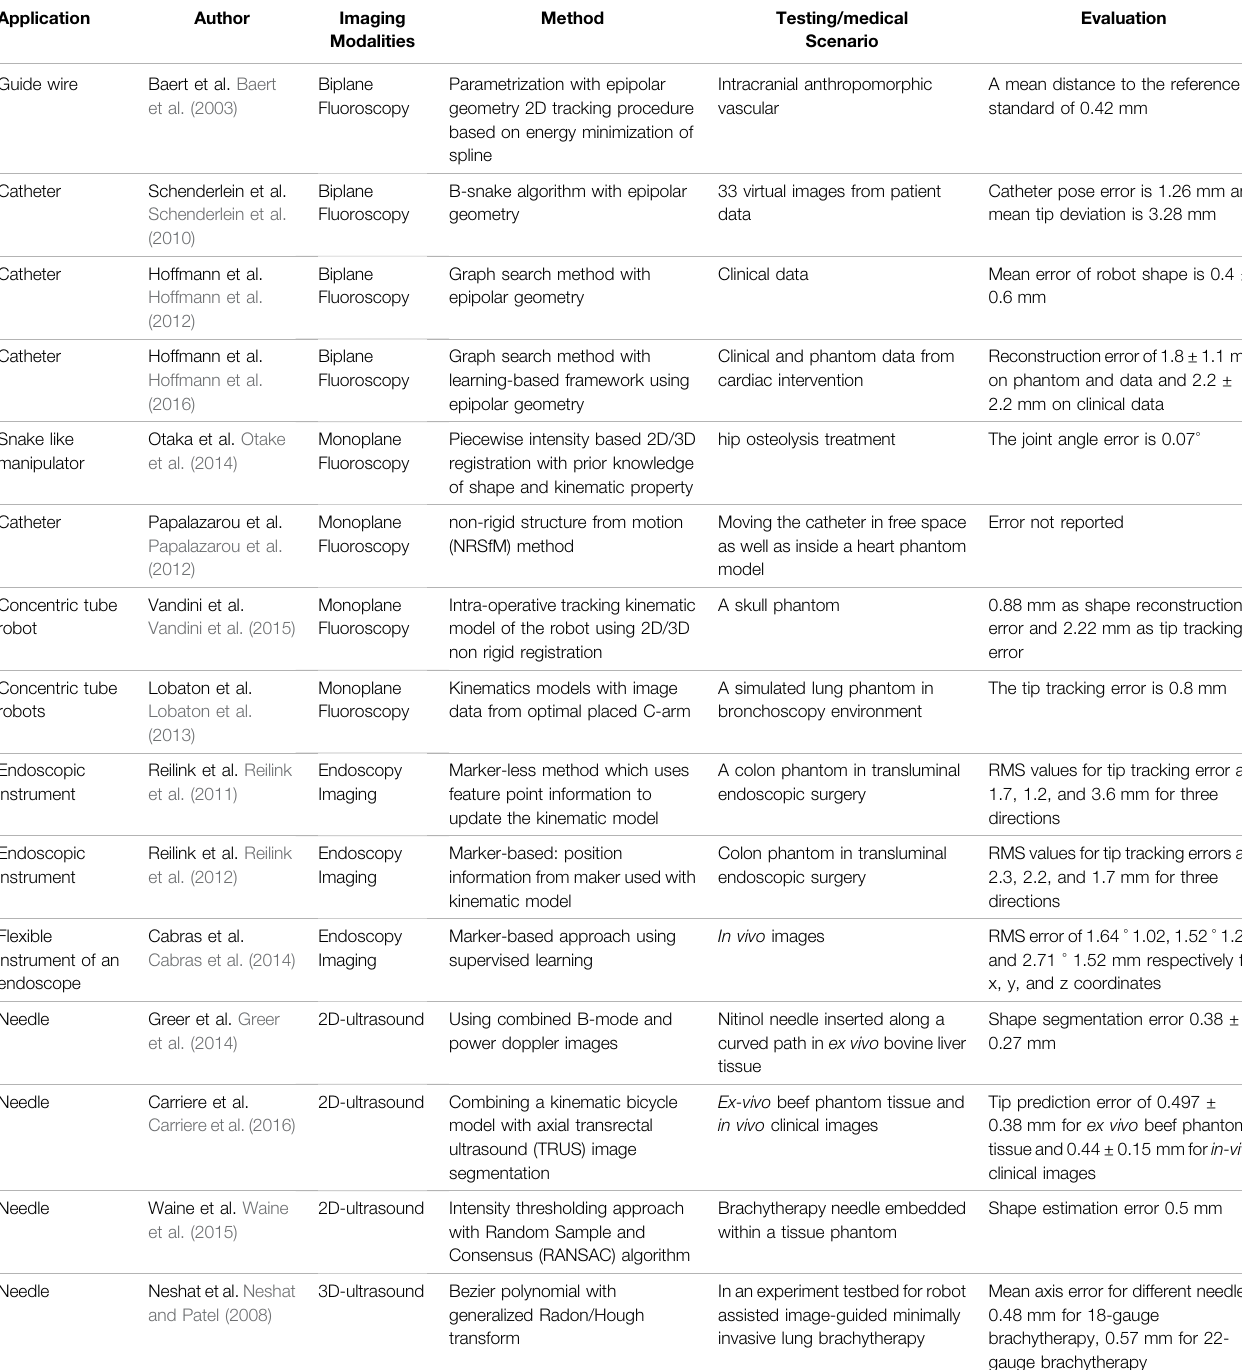
TABLE 4 | Summary of medical imaging-based shape reconstruction